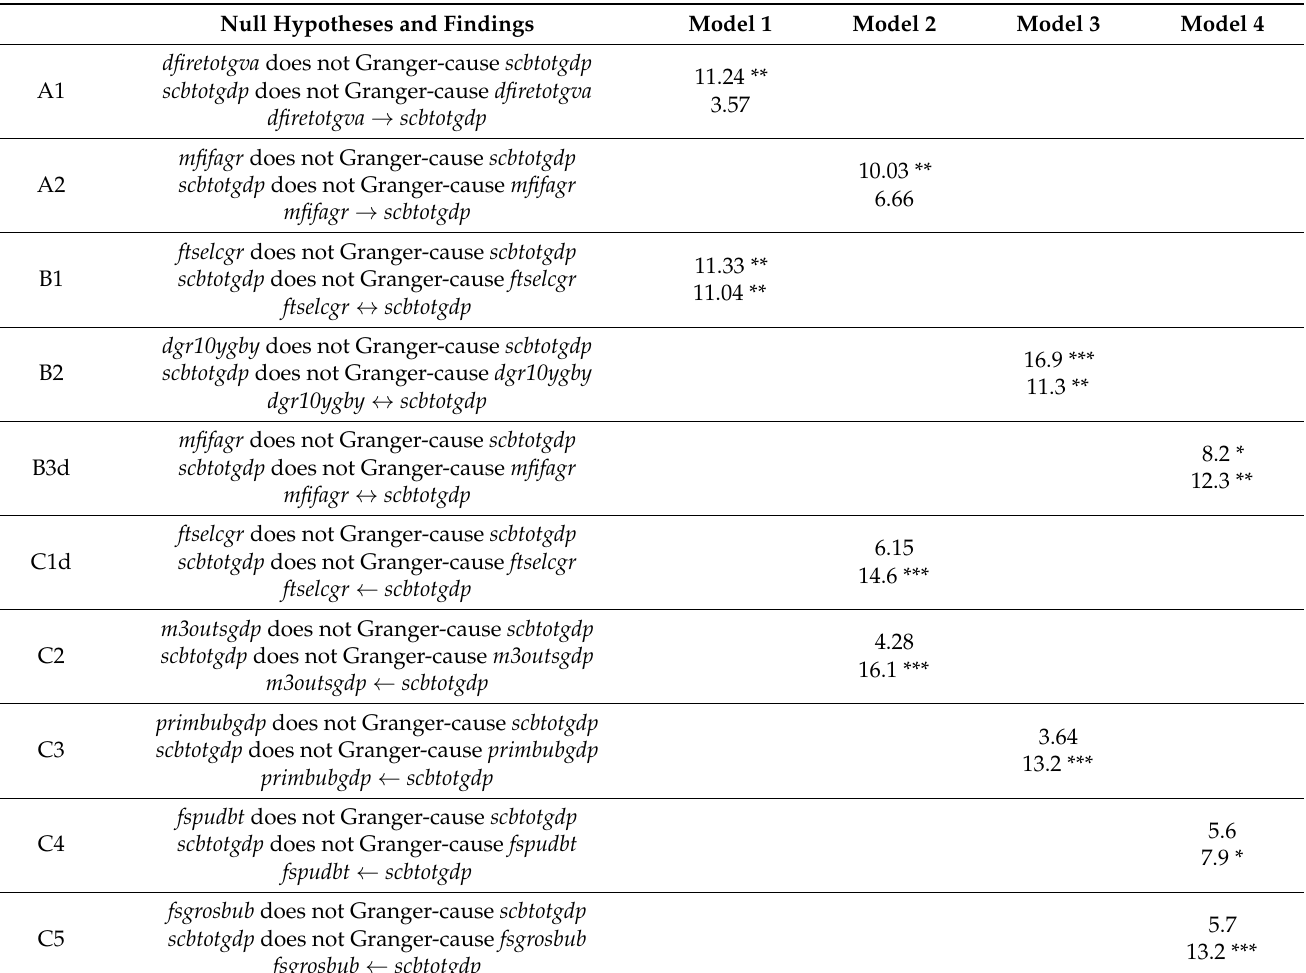
Table 4. Granger causality Wald tests of Social Contributions and Benefits Paid (scbtotgdp) vs. Financialization’s